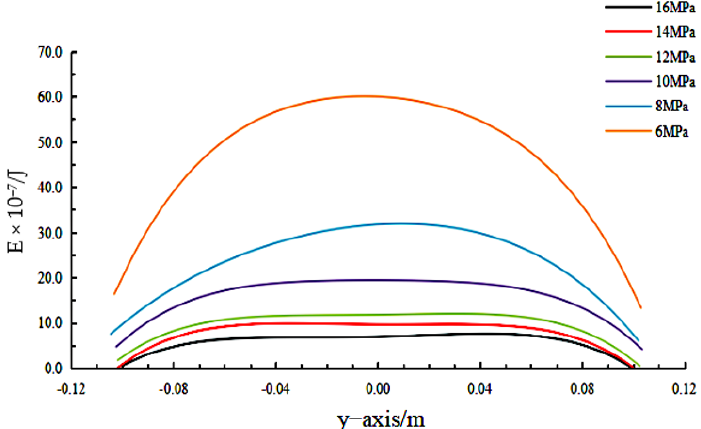
Figure 23. Fitting curve of kinetic energy E radial distribution of paint.